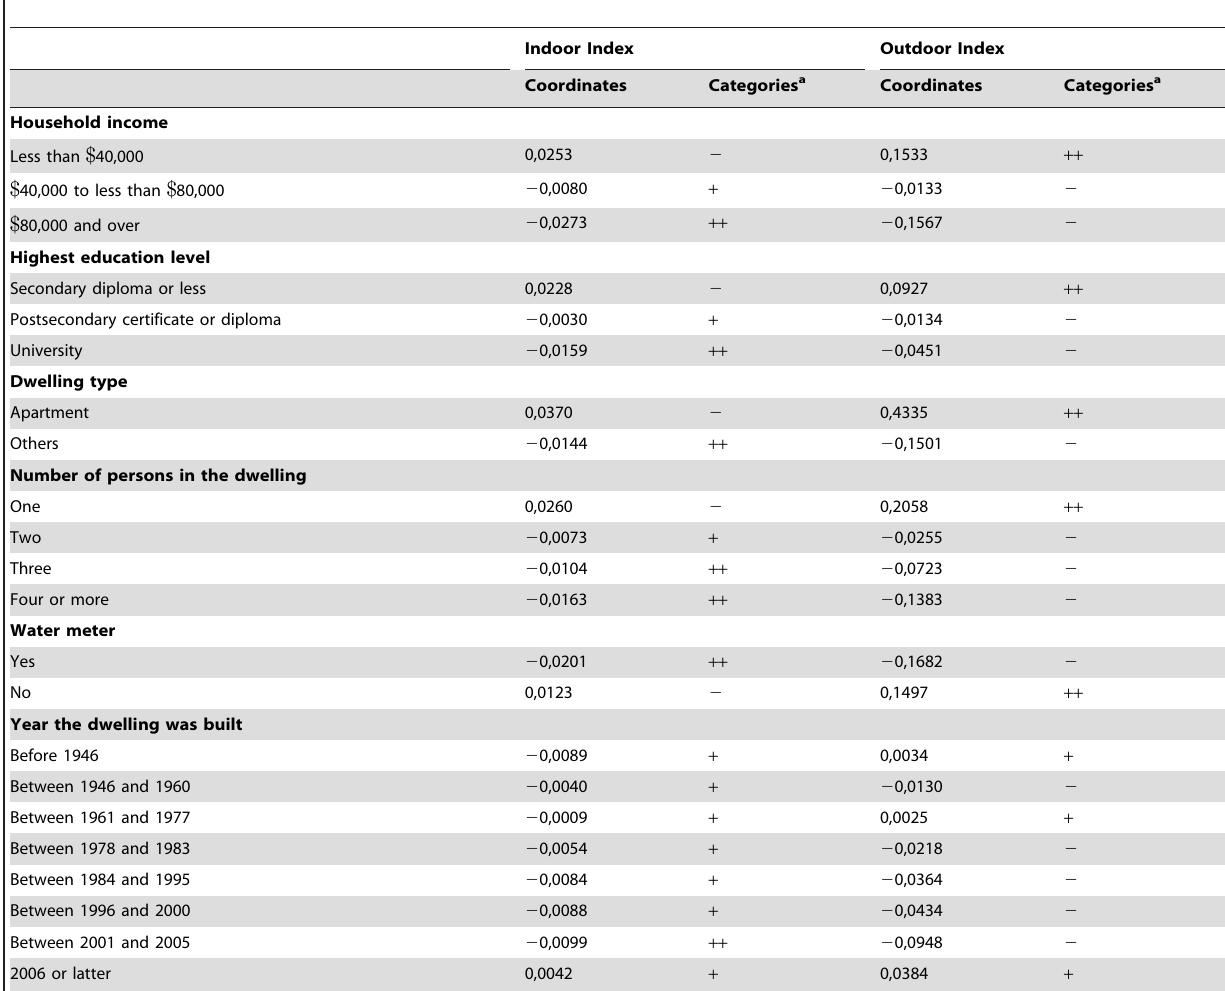
Table 5. Coordinates and categories of pro-environmental behaviours for other socio-demographic variables, Indoor and Outdoor Indices,